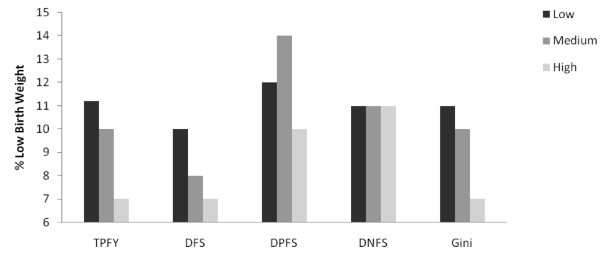
Median percent low birth weight by total proportion of free years (TPFY), duration of free status (DFS), duration of partially free status (DPFS), duration of not free status (DNFS), and Gini coefficient.